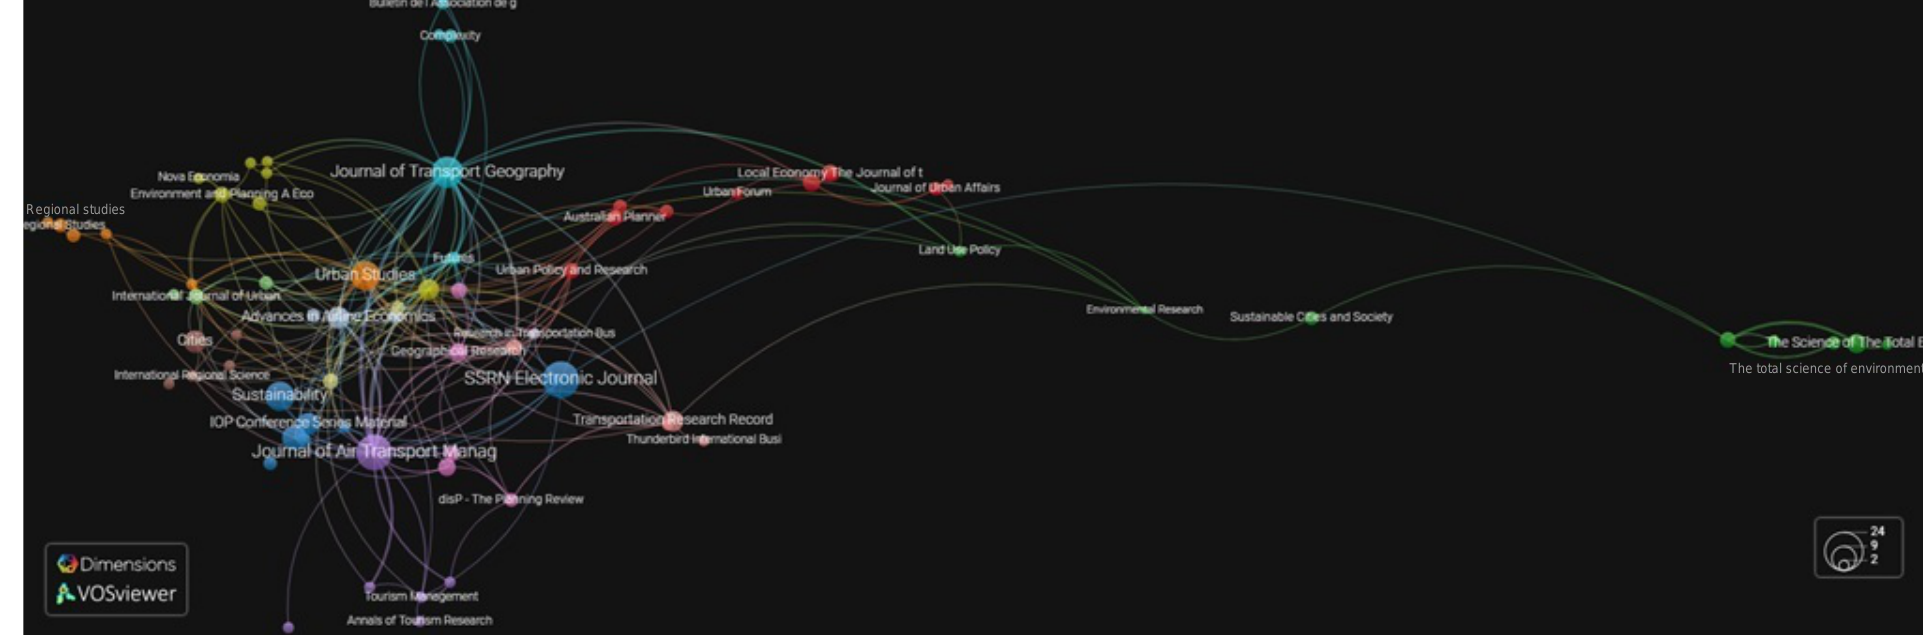
Figure 12. Journals publication